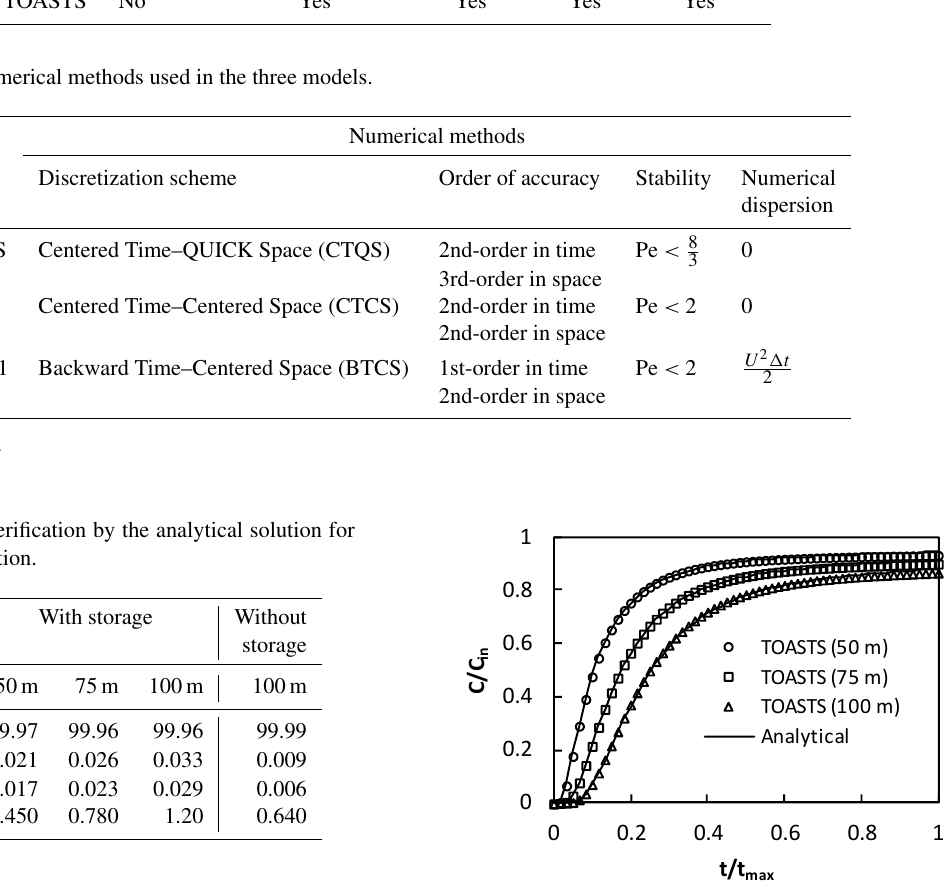
Figure 1. Results of the TOASTS model verification by the analyt- ical solution for continuous boundary condition ( α (cid:54)=